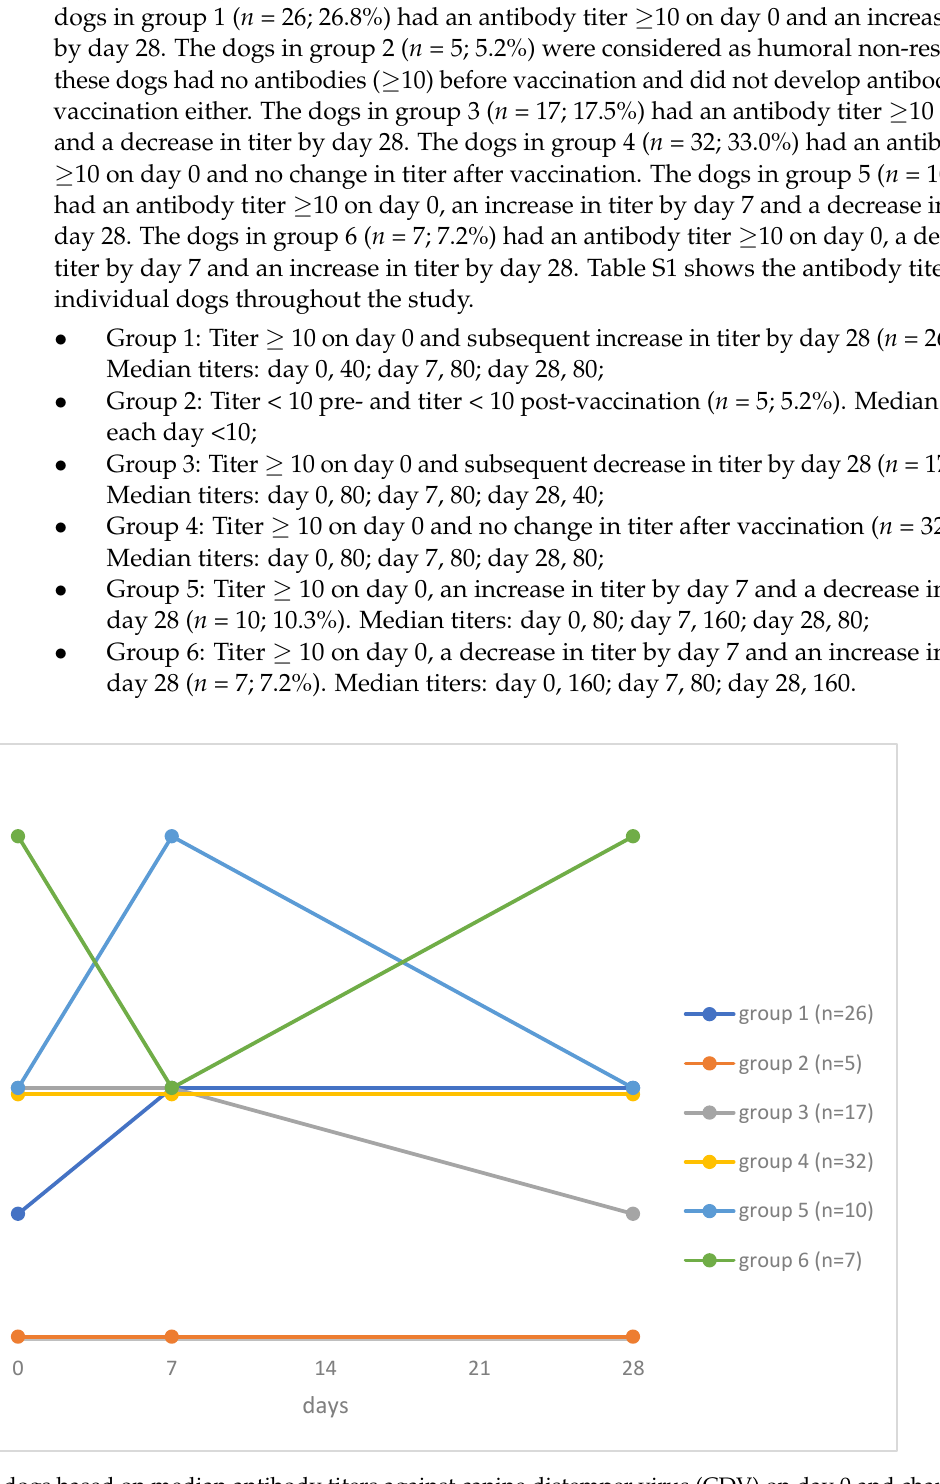
Figure 2. Grouping of dogs based on median antibody titers against canine distemper virus (CDV) on day 0 and changes in titer after vaccination against CDV in virus neutralization (VN) testing using isolate AG219. The antibody titers of the individual dogs are given in Table S1.